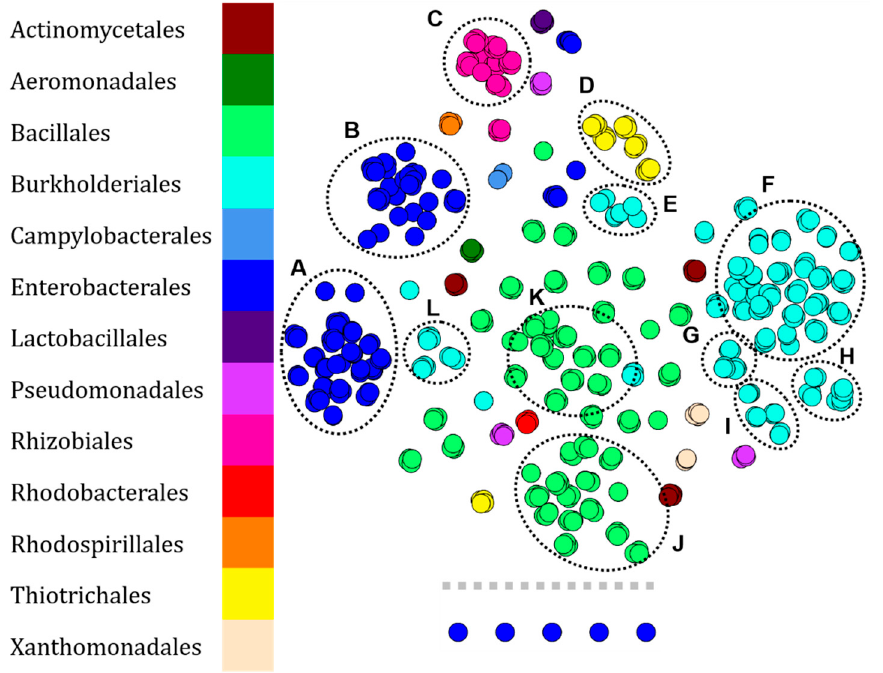
Figure 2. Visualization of 568 protein fingerprints of pathogenic bacteria (166 strains) from a part of the RKI data set by t-SNE. Each node represents the protein fingerprint of a clinical isolate identified at RKI and is colored according to the taxonomic order of the organism. The observed clusters were noted from A to L.